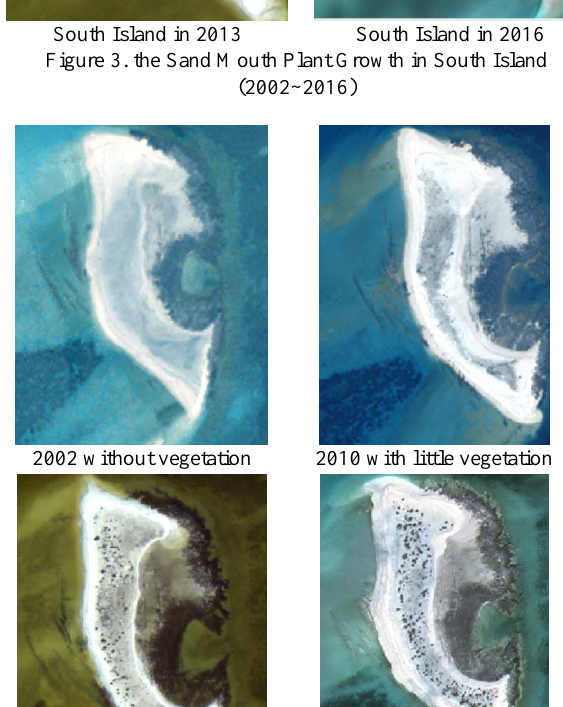
Figure 3. the Sand Mouth Plant Growth in South